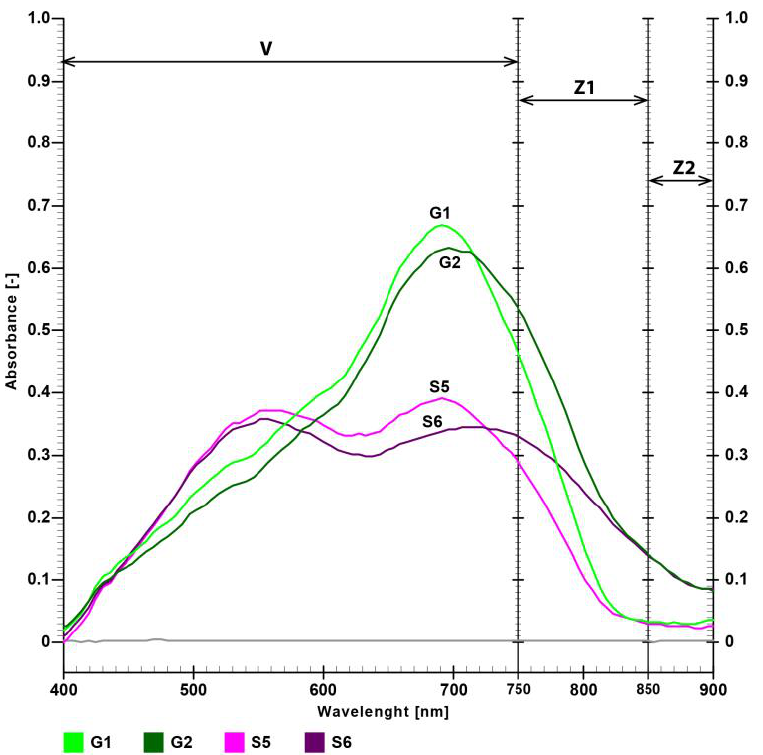
Figure 12. Comparison of the spectrographs for the Green and Dark Red process twin